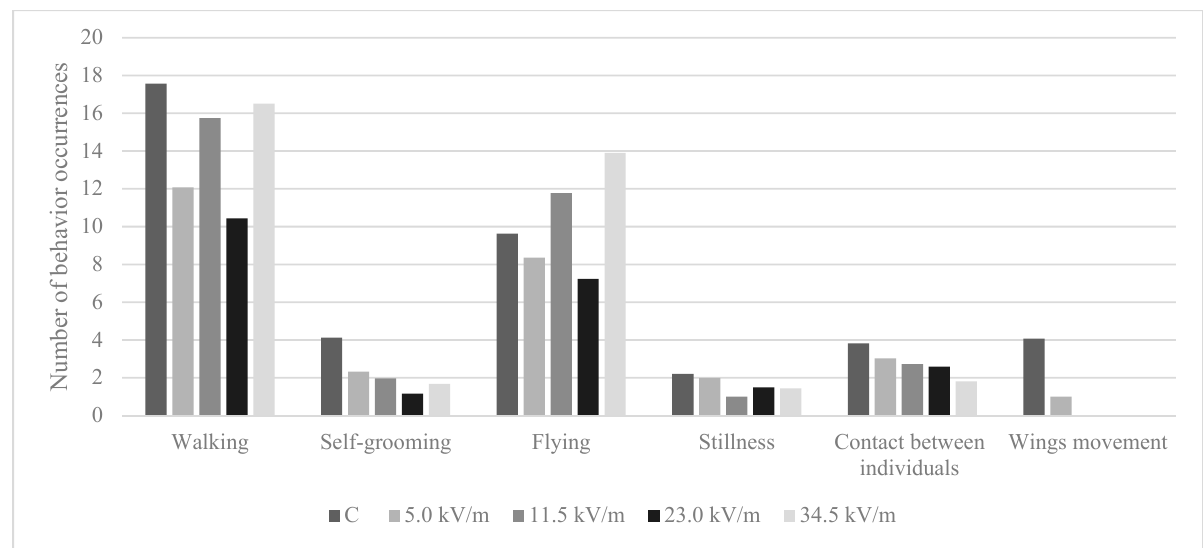
Figure 2. The average number of behavior occurrences displayed by bees after 12 h under the influence of an E-field at 50 Hz and an intensity of 5.0 kV/m, 11.5 kV/m, 23.0 kV/m, or 34.5 kV/m. The group name is the E-field intensity to which the bees were exposed. The control group is marked with the letter C.